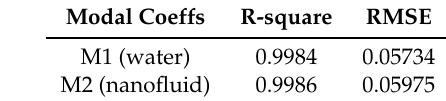
Table 8. Root mean square (RMSE) and correlation coefficient (R-square) values for water and nanofluid model.